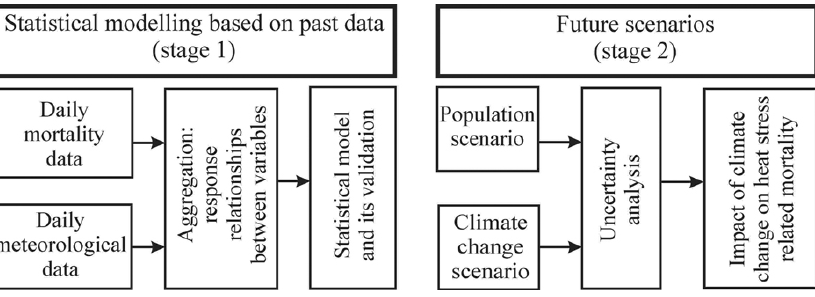
Fig. 1. Scheme of research (adapted from Gosling et al .